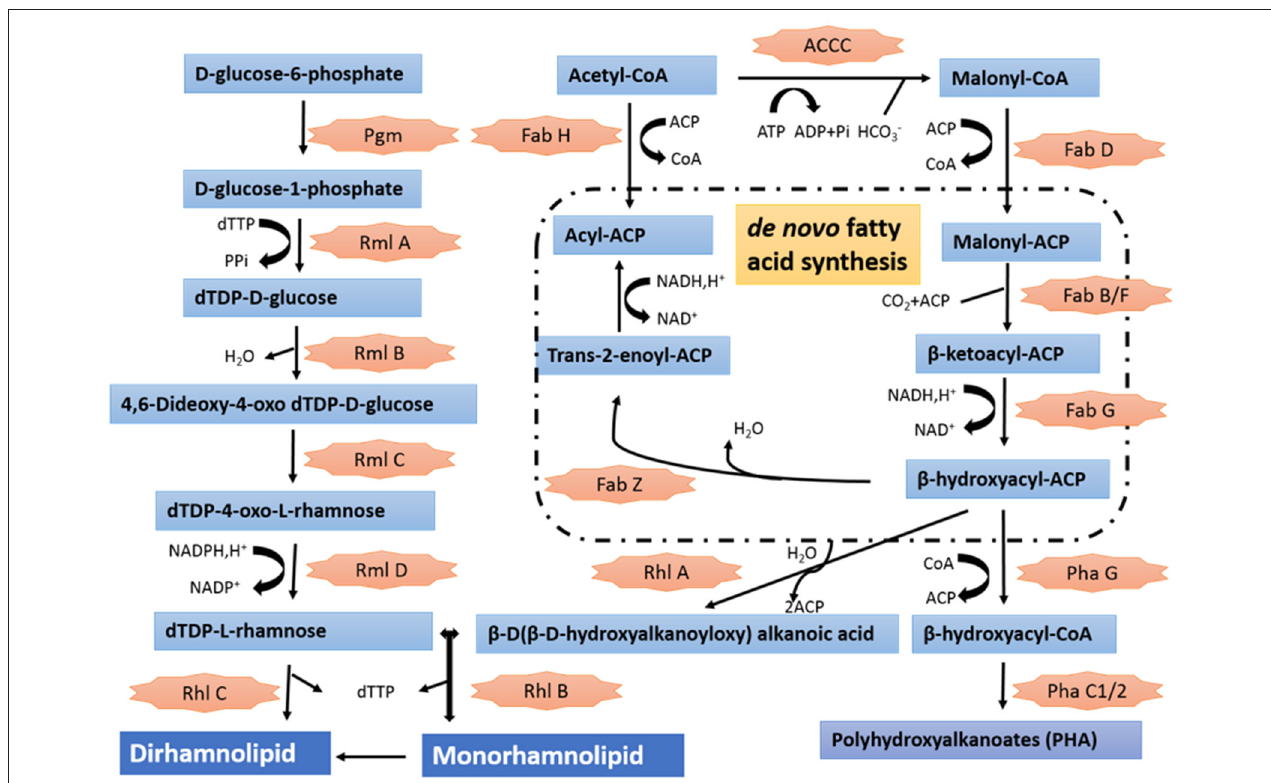
FIGURE 4 | Putative metabolic pathway involved in the synthesis of rhamnolipid in genome of P. rhisophila S211. Pgm, Phosphoglucomutase, EC 5.4.2.2; RmlA, Glucose-1-phosphate thymidylyltransferase, EC 2.7.7.24; RmlB, dTDP-glucose 4,6-dehydratase, EC 4.2.1.46; RmlC, dTDP-4-dehydrorhamnose 3,5-epimerase, EC 5.1.3.13; RmlD, dTDP-4-dehydrorhamnose reductase, EC 1.1.1.133; RhlB and RhlC, Glycosyltransferase, EC 2.4.1.; PhaG, (R)-3-hydroxydecanoyl-ACP:CoA transacylase PhaG (3-hydroxyacyl-CoA-acyl carrier protein transferase), EC 2.4.1.-; PhaC1/2: Polyhydroxyalkanoic acid synthases, EC 2.3.1-; ACCC, Acetyl-coenzyme A carboxyl transferase alpha chain, EC 6.4.1.2; FabD, Malonyl CoA-acyl carrier protein transacylase, EC 2.3.1.39; Fab H, 3-oxoacyl-[acyl-carrier-protein] synthase, KASIII, EC 2.3.1.180; FabB/F, 3-oxoacyl-[ACP] synthase, EC 2.3.1.41; FabG, 3-oxoacyl-[acyl-carrier protein] reductase, EC